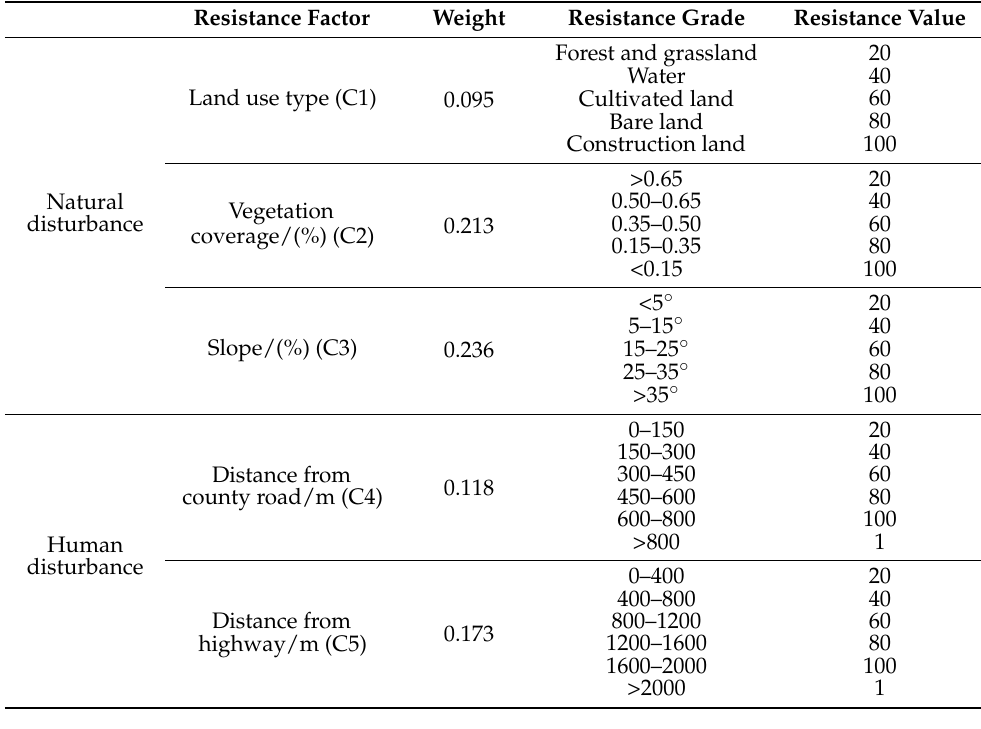
Table 2. Factor grade and weight in the ecological resistance analysis.